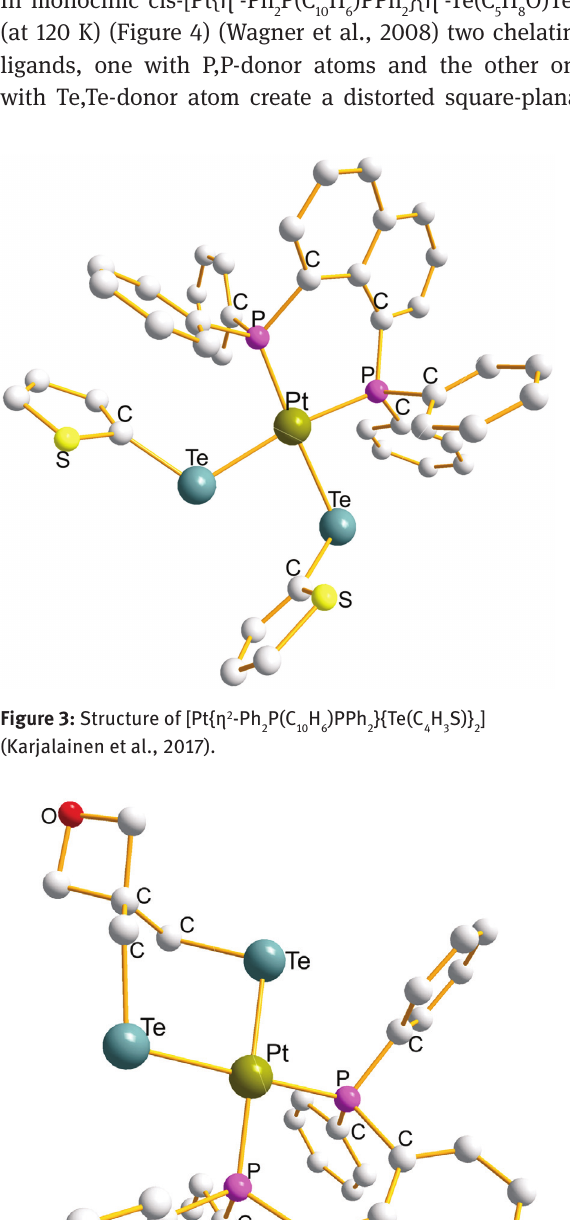
P(C H )PPh }{η 2 -Te(C 2 10 6 2